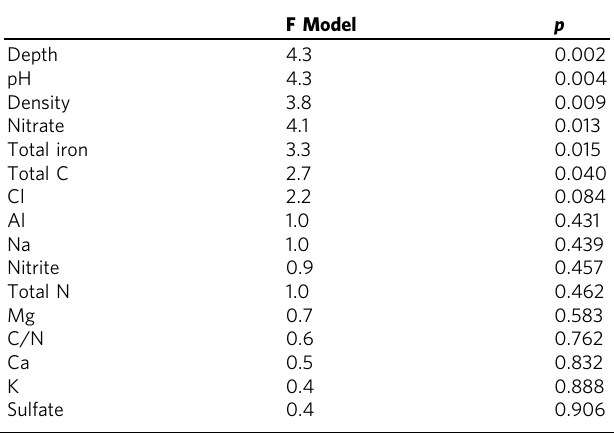
Table 1 Signi fi cant contributions of soil geochemistry to observed differences in prokaryotic diversity in permafrost were tested using ANOVA (df =